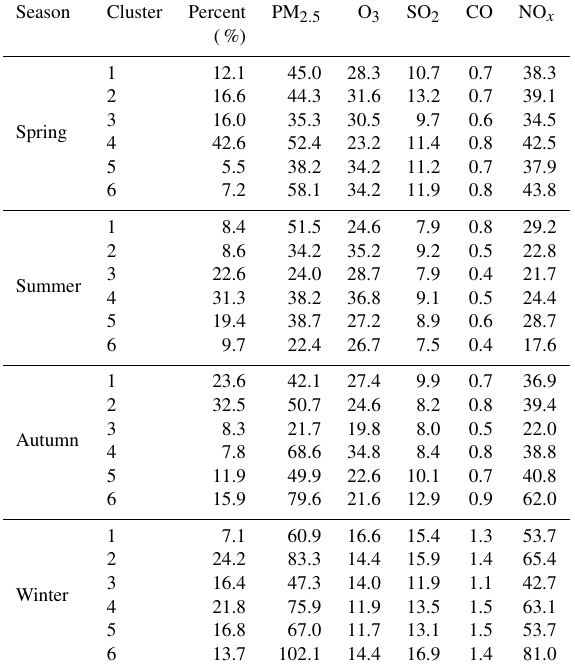
Table 3. Mean concentrations of PM 2 . 5 (µgm − 3 ) and other trace gases (units of ppmv for CO but ppbv for other gases) in the identi- fied trajectory clusters within the four-season period, together with the percentages of each trajectory